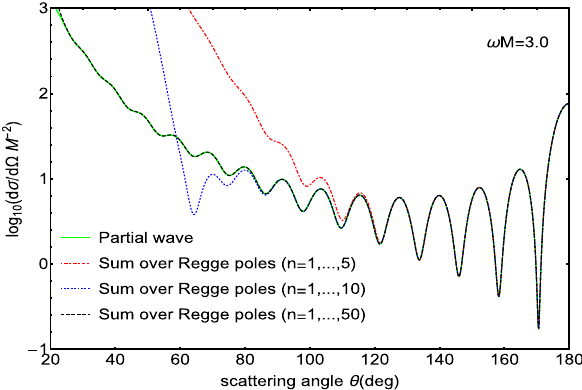
Fig. 11 Comparison of the scattering cross sections obtained via the partialwavemethodandtheReggepoleapproximations.Theblackhole charge is q = 0 . 3